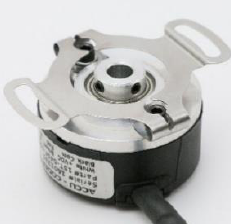
Figure 5. Encoder products company model 15T rotary encoder.